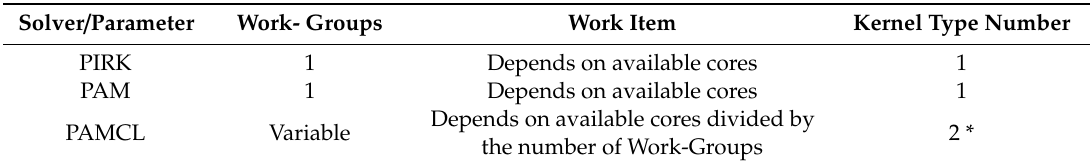
Table 1. The kernel configuration for each of the solvers. * The PAMCL solver has two di ff erent types of kernels, the first one without overshooting and the second one with overshooting. If the number of cores is more than 32, the second kernel type is the one to be used.